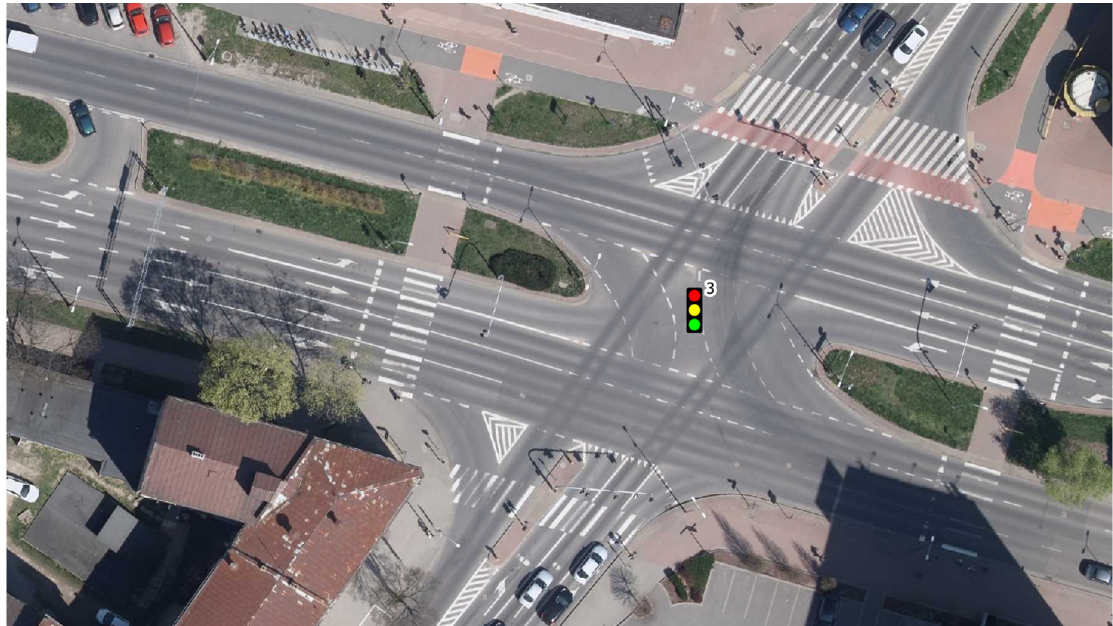
Figure 5. Traffic organization at intersection No. 3. (Background map Head Office of Geodesy and Cartography). During the measurements at the intersection, signaling programs with a cycle duration of 100 s (06:30–08:00) and 95 s (08:00–08:30) operated. The green signals had a duration of 35 s and 26 s, respectively.